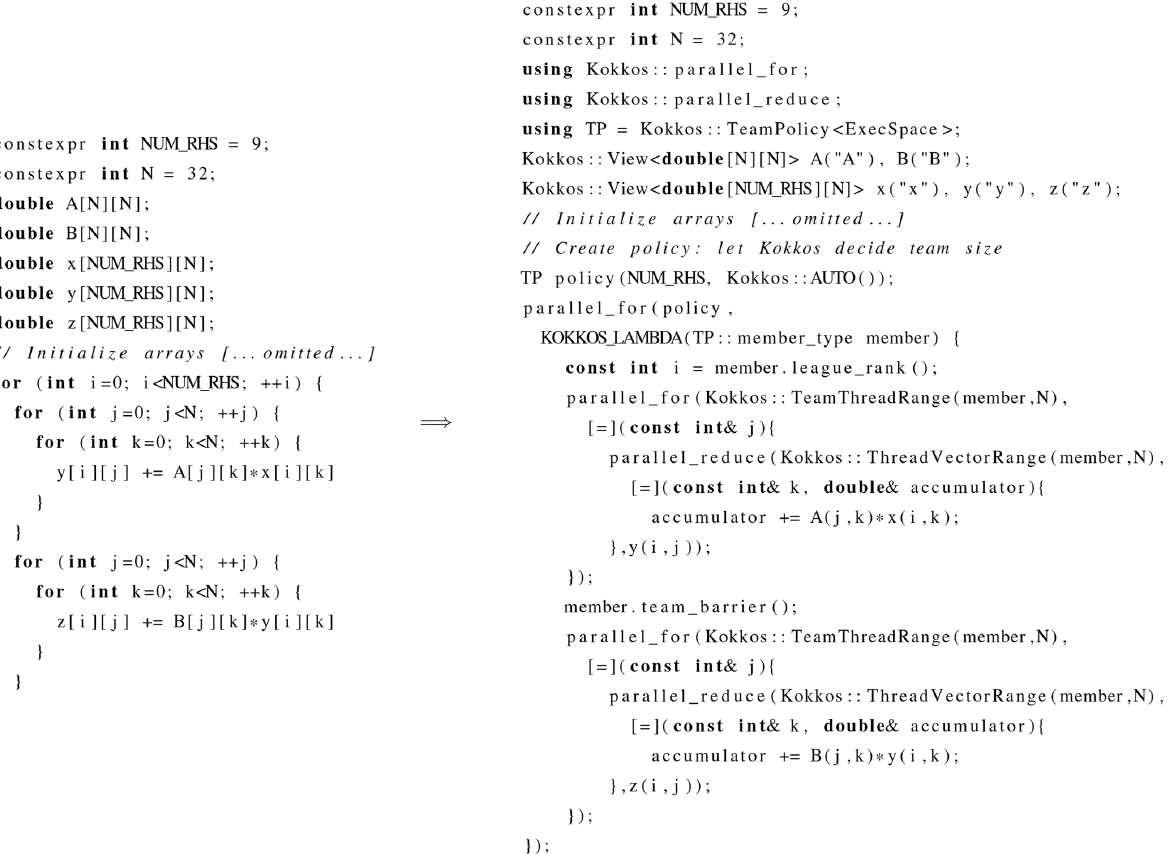
Figure 6. Parallelization of non-tightly nested loops via team policy. The team policy is determined by the number of outer iterations and the number of threads per team. Each team is assigned a subset of the outer iterations and, within a single outer iteration, can expose more parallelism by dividing the work among the threads in the